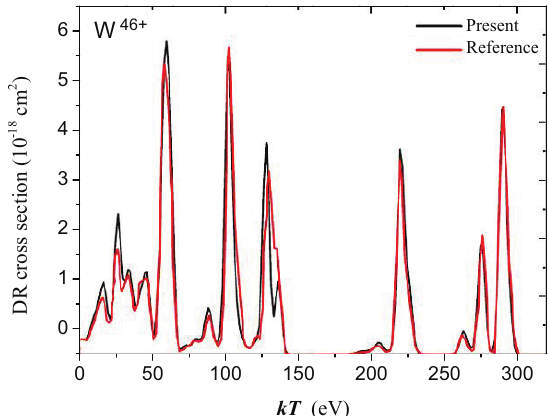
Figure 4. The presently calculated DR cross-sections for the 3 d 10 + e − → 3 d 9 4 l 4 l (cid:48) → 3 d 10 4 l (cid:48)(cid:48) + hν processes of W 46+ ions as a function of electron energy kT available results [29].